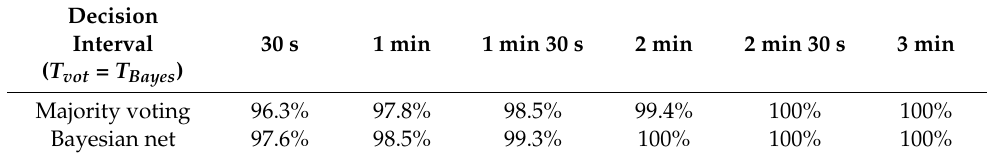
Table 13. Accuracy comparison depending on the decision interval and Bayesian network [26]. Decision